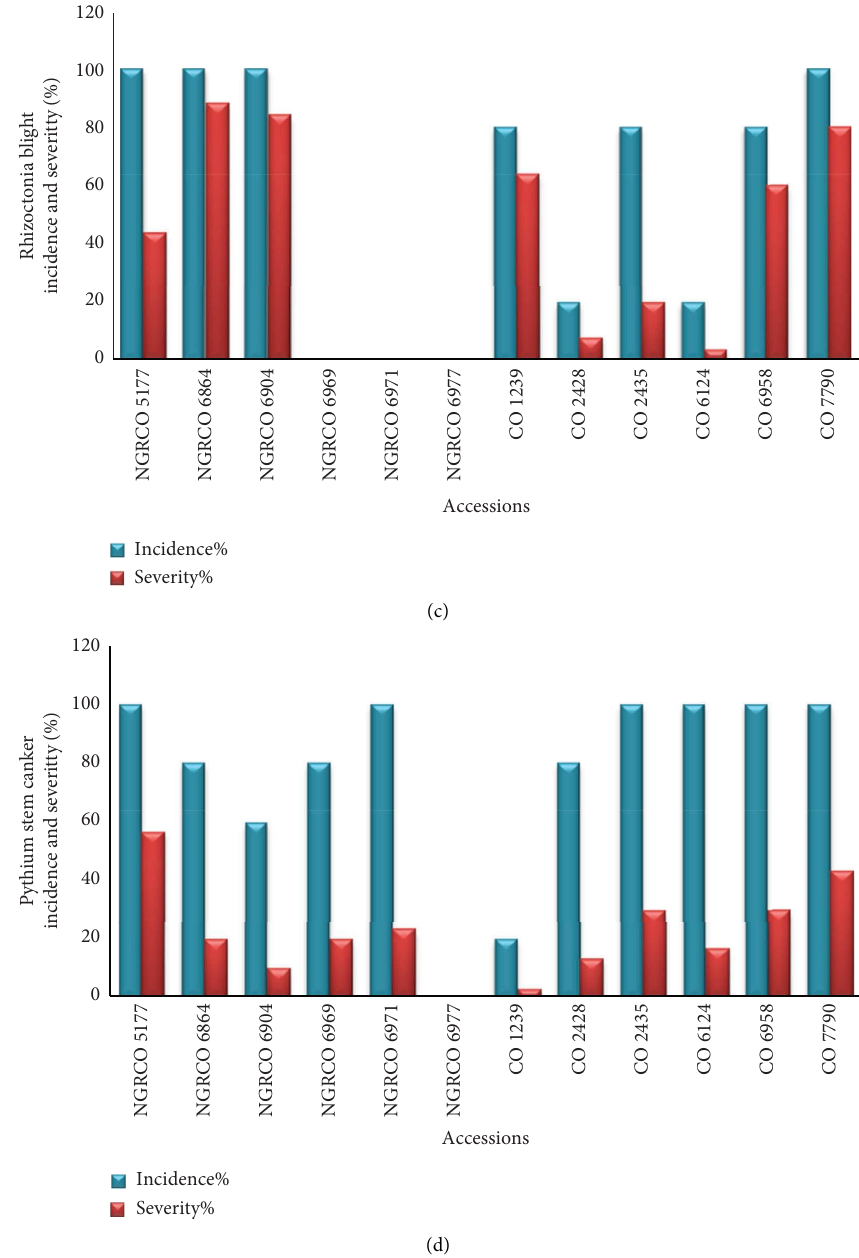
Figure 2: Incidence and severity percentage of twelve amaranth accessions for (a) anthracnose, (b) Cercospora leaf spot, (c) Rhizoctonia blight, and (d) Pythium stem canker.